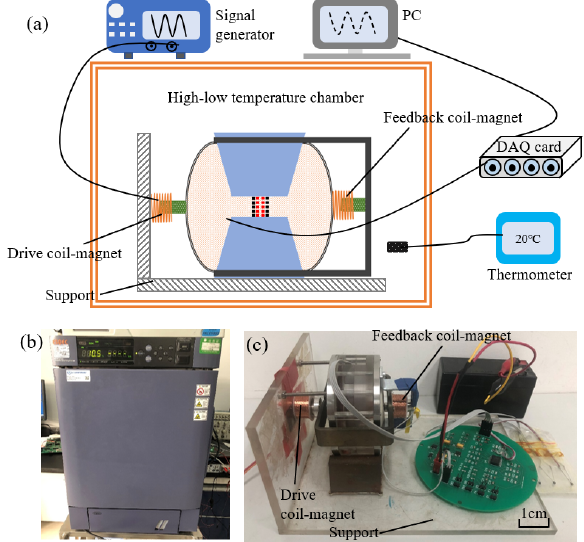
Figure 4. ( a ) The platform for temperature characteristic test, in which a high-low temperature chamber was used. ( b ) The image of the high-low temperature chamber. ( c ) The electrochemical seismic sensor with feedback coil-magnet and drive coil magnet, tested in the temperature chamber.